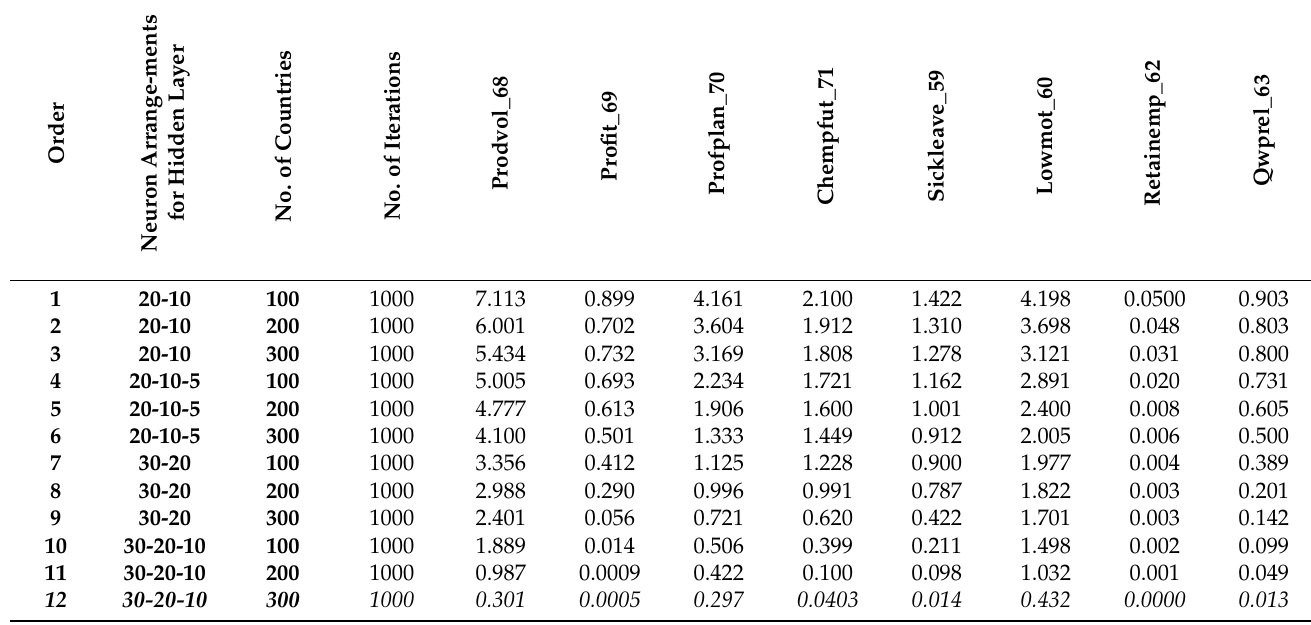
Table 2. Training MAPE for the effect of skill requirements on